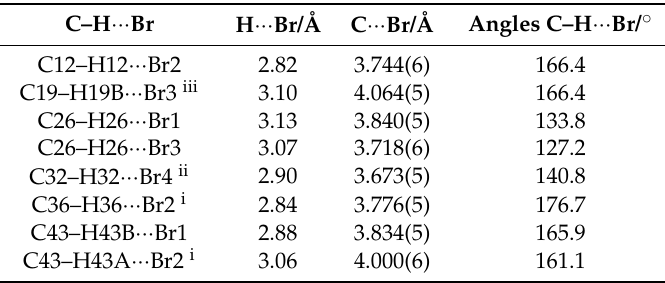
Table 5. Hydrogen bond geometry for (HexPh 3 P) 2 [CuBr 4 ] ( 8 ).